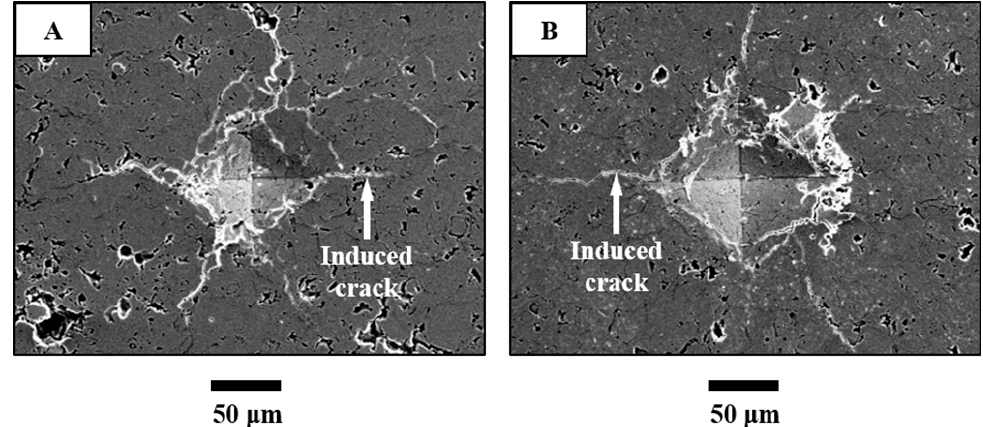
Figure 1. Surface images of Thermal Barrier Coatings (TBCs) with cracks induced by indentation: ( A ) 30 N and ( B ) 50 N.